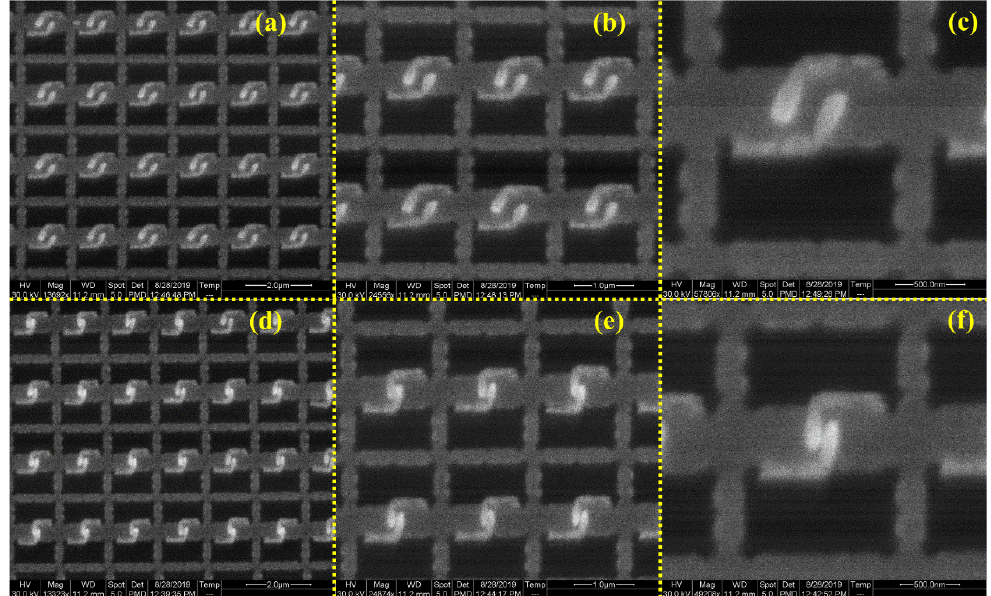
Figure 8. CL (cathodoluminescence) images of the 3D meta-atom arrays with different claw gaps. ( a – c ) CL images of the same 3D meta-atom arrays with larger claw gaps in different magnifications, and ( d – f ) CL images of the same 3D meta-atom arrays with smaller claw gaps in different magnifications. The scale bars are 2 μm for ( a , d ), 1 μm for ( b , e ) and 500 nm for ( c , f ).